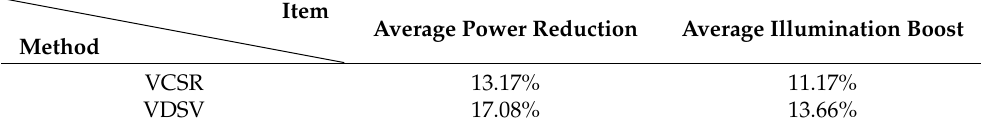
Table 4. Quantified improvement effect for the full dimming range.